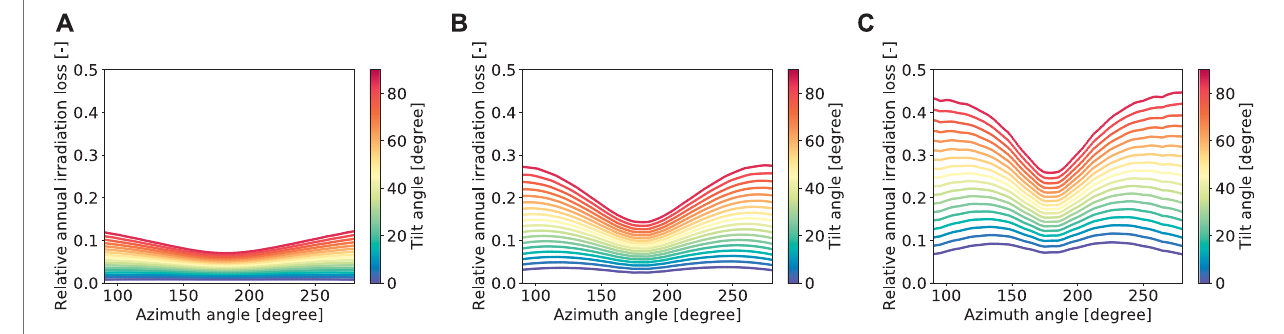
FIGURE 6 | Irradiation loss of PV panel shadowing for different design limiting angles β . (A) β (cid:2) 10 degree, (B) β (cid:2) 20 degree, (C) β (cid:2) 30